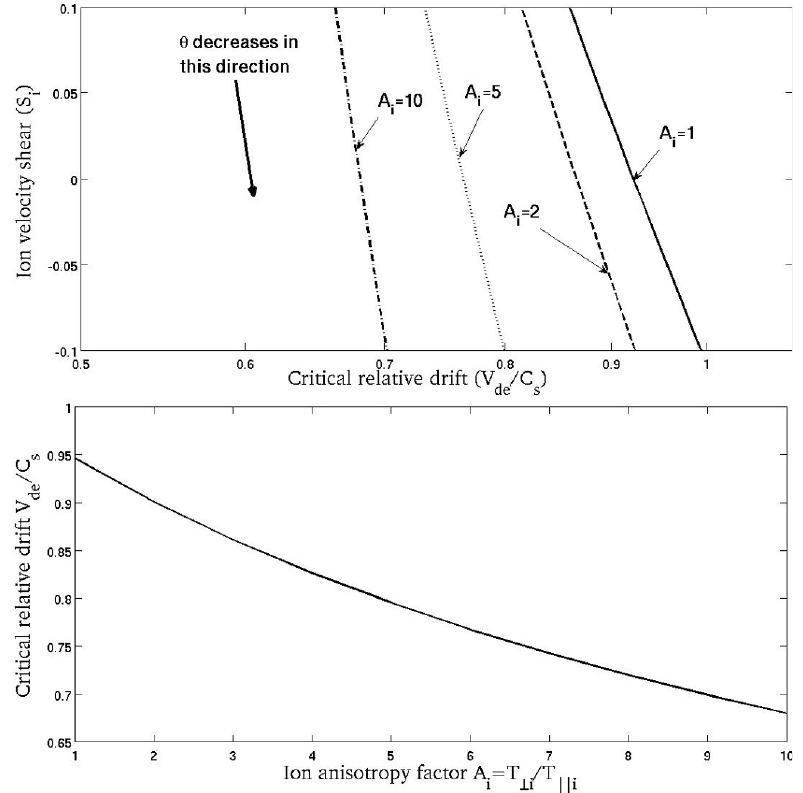
Fig. 2. Threshold conditions for the shear CDEIA instability in an anisotropic O + plasma using Eq. (9), ω R /kC s = 0 . 5 and (cid:127) i /kC s = 2. S i as a function of V de /C s is presented in the top panel for A i from 1 (solid), 2 (dashed), 5 (dotted) and 10 (dashed-dotted). Equation (9) is plotted in bottom panel for θ = 47 ◦ and S i =